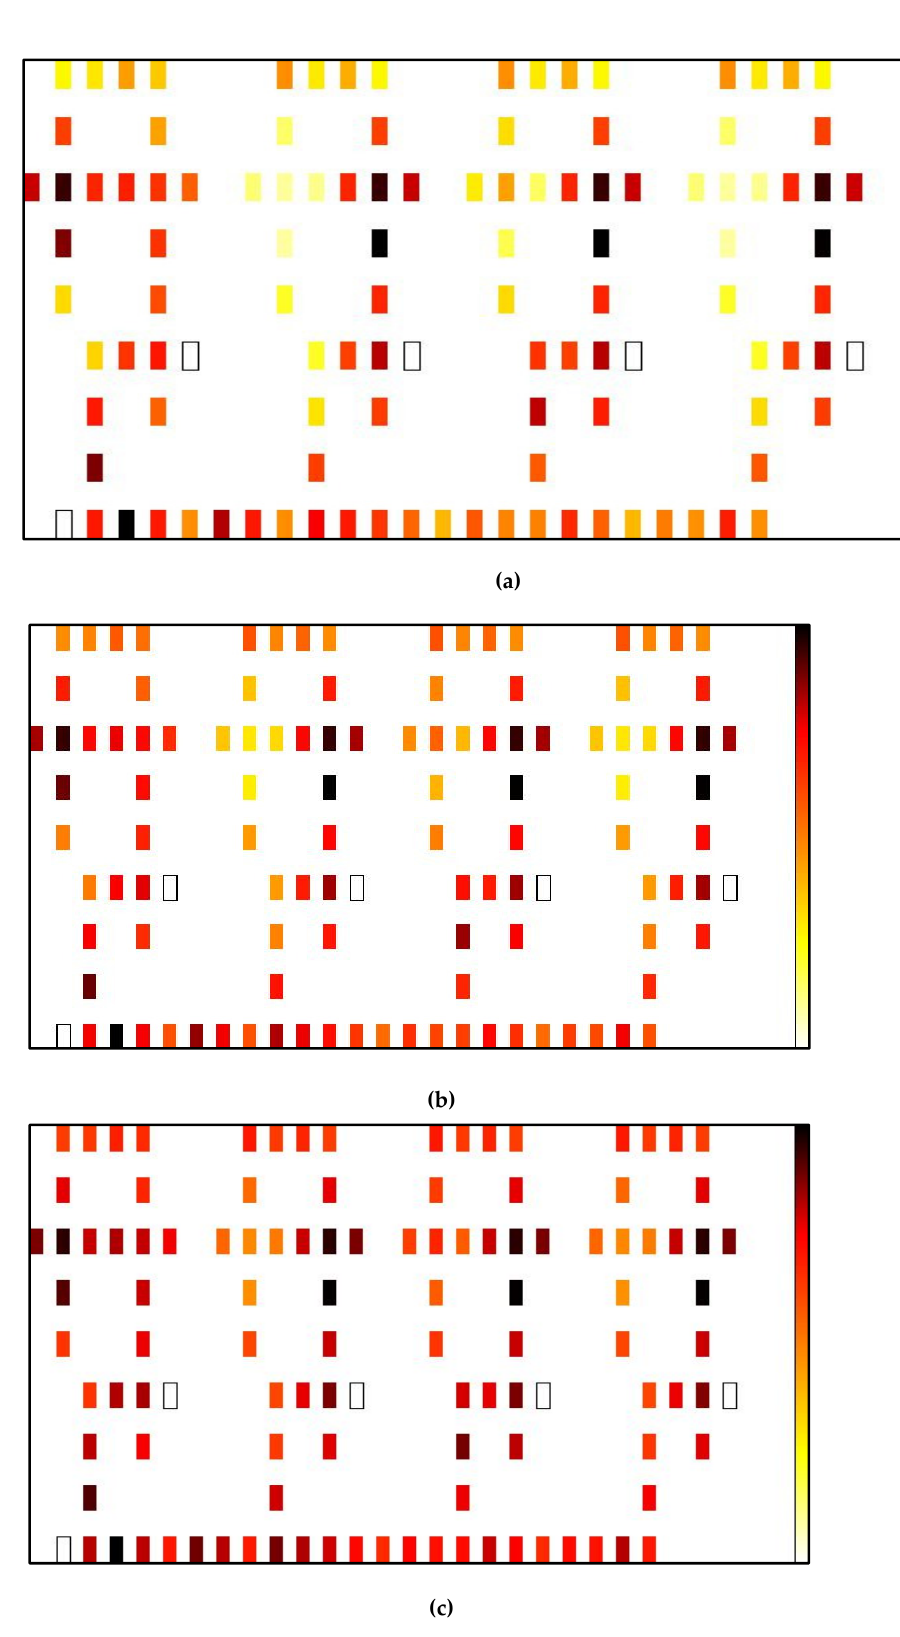
Figure 23. Map of energy dissipation for proposed 2-bit PIPO shift register at T = 2K and ( a ) 0.5 Ek,